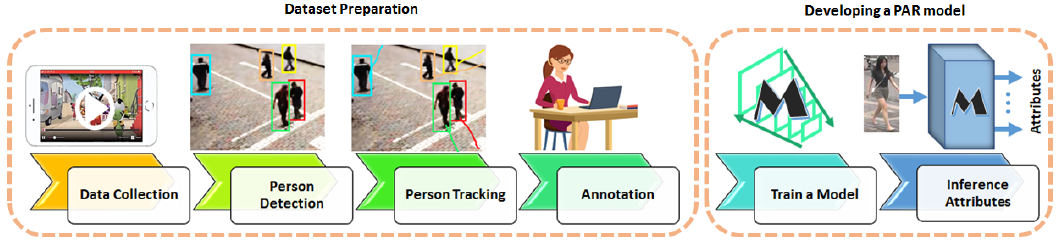
Figure 1. Typical pipeline to develop a HAR